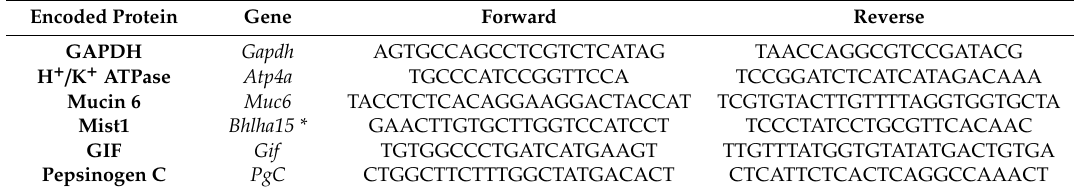
Table 1. Primers used for detection of gene expression after qPCR in ontogenic analyses.